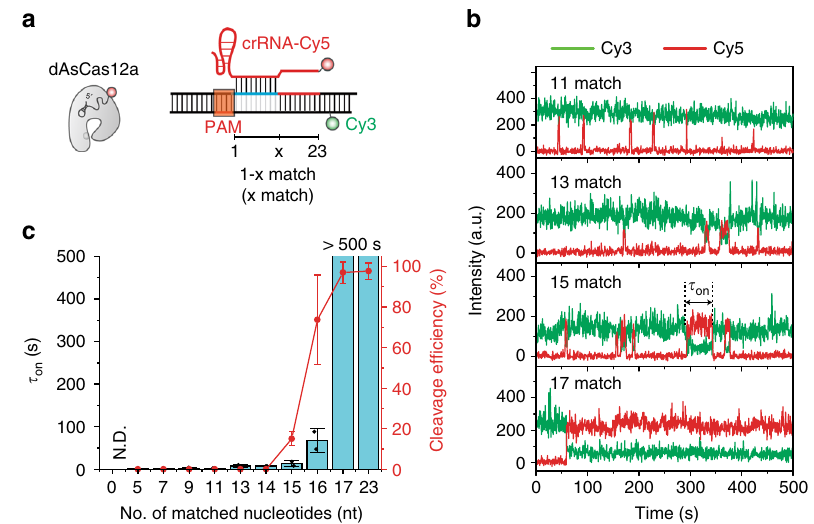
Fig. 4 Stability of AsCas12a on partially cognate DNA templates. a Diagram of designed Cy3-labeled DNA templates and Cy5-labeled crRNA. Part (1 − x nt) of the protospacer is complementary to the crRNA. Catalytically deactivated dAsCas12a was used to avoid additional complexity from DNA cleavage activity. b Representative time traces of Cy3 and Cy5 fl uorescence intensity that show binding and unbinding activity of AsCas12a on each DNA template (with 11, 13, 15, 17 matched nucleotides). AsCas12a-binding results in FRET. c The dAsCas12a dwell time and cleavage ef fi ciency versus the number of matched nucleotides. The dwell time is represented by blue bars and the cleavage ef fi ciency by red dots. The dwell time ( τ on ) was extracted from time traces as in b and fi tted with a single exponential decay function. At least 111 time traces are analyzed from two independent experiments (254 for 0 match; 495 for 5 match; 333 for 7 match; 343 for 9 match; 318 for 11 match; 401 for 13 match; 206 for 14 match; 325 for 15 match; 317 for 16 match; 201 for 17 match; and 111 for 23 match). The cleavage ef fi ciency was assessed by in vitro cleavage assay using agarose gel electrophoresis (Supplementary Figure 5). The error bars mean the standard deviation ( n = 3). All FRET experiments in this fi gure were performed under the same reaction conditions (10 nM AsCas12a, 20 nM crRNA, 10 mM Tris-HCl (pH 8.0), 100 mM KCl, 10 mM MgCl 2 , and 1 mM